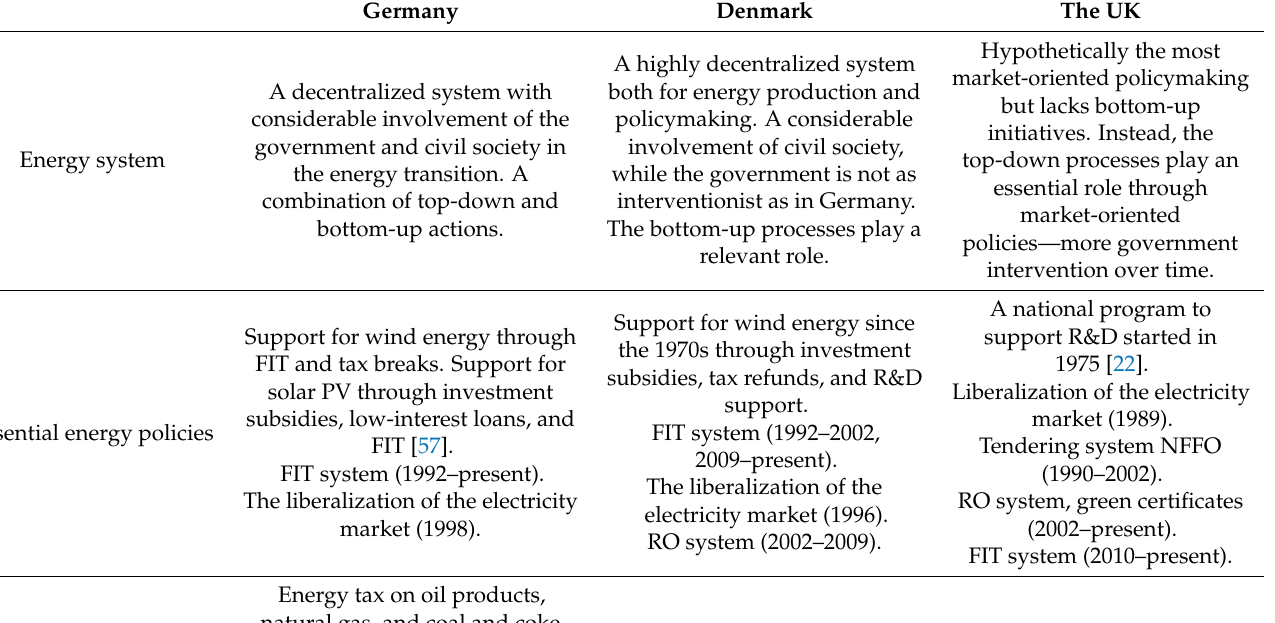
Table 1. Energy industry systems and energy policies of Germany, Denmark, and the UK,